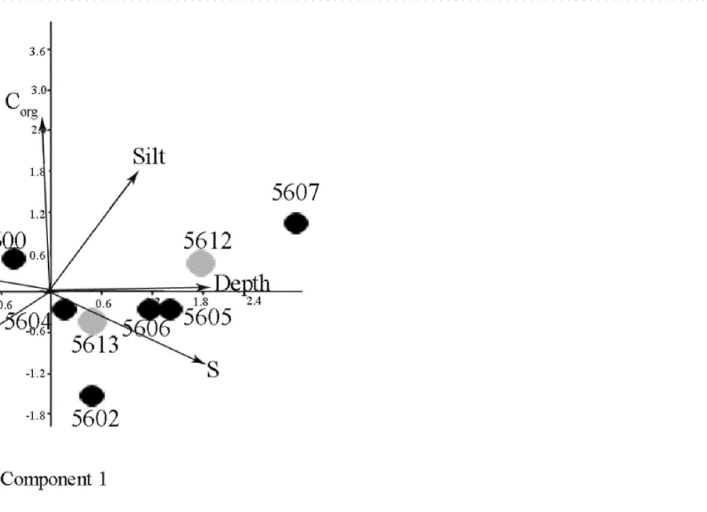
Figure 3. Principal component analysis based on the environmental factors (Depth, S—salinity, T— temperature, O 2 —oxygen saturation, Silt—silt content, C org —total organic carbon content). PC1 explained 48% of total variation, PC2—27%. Black circles indicate stations in Indigirka river, grey circles in Kolyma